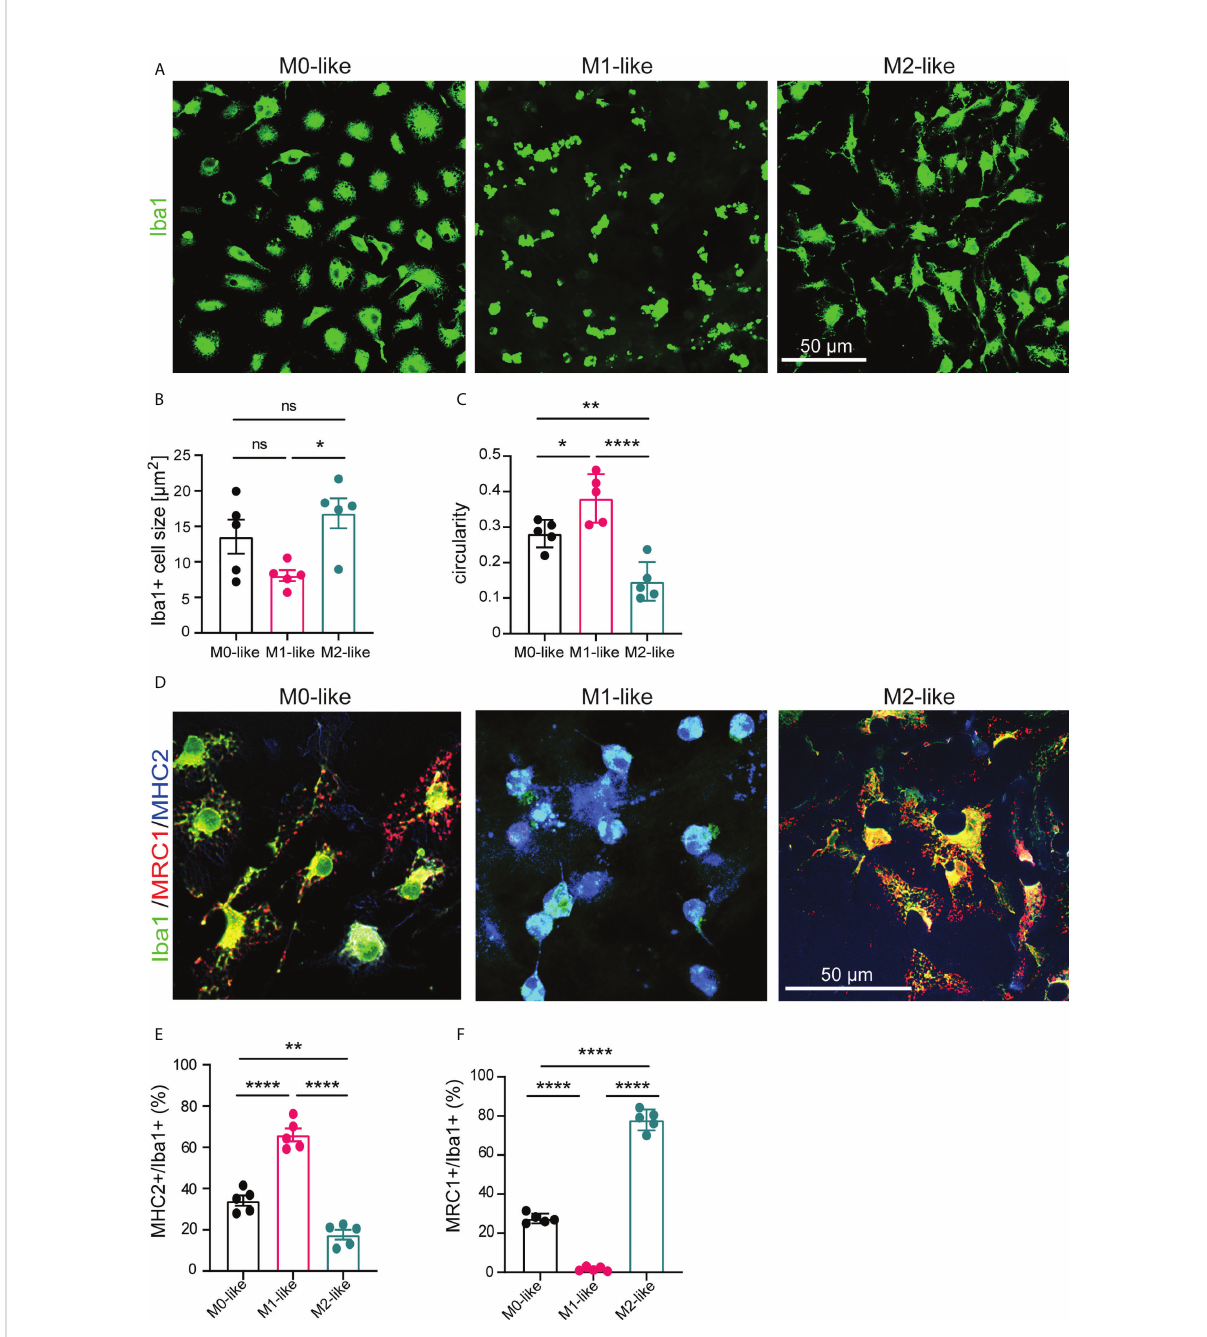
FIGURE 1 Microglia subtypes differ in morphology and expression of M1/M2 protein markers. (A) Confocal images showing anti-Iba1 immunostaining of M0-, M1-, and M2-like microglia subtypes in primary glia cultures at 7 div, cultivated the presence of serum and/or growth factors and cytokines (GM-CSF/IFN g for M1-like or M-CSF/IL-4 for M2-like) (B) Histograms showing differences in mean cell size and (C) circularity of microglia subtypes. (D) Confocal images showing triple-immunostaining using antibodies speci fi c to the pan-marker Iba1, the M1-marker MHC2, or the M2-marker MRC1. M1- or M2-like microglia show increased expression of MHC2 or MRC1, respectively. (E, F) Histograms showing the percentage of Iba1+ microglia expressing MHC2 or MRC1 as determined by cell counts after triple immunostaining using antibodies speci fi c to Iba1, MHC2, or MRC1. Data are expressed as mean ± SEM (n = 5, independent biological replicates are shown) and were tested for signi fi cant differences by one-way ANOVA ( post-hoc correction Holm-S ̌ ı ́ da ́ k) or Kruskal-Wallis test ( post-hoc correction Dunnett), *p < 0.05, **p < 0.01, ****p < 0.0001 ns, not signi fi